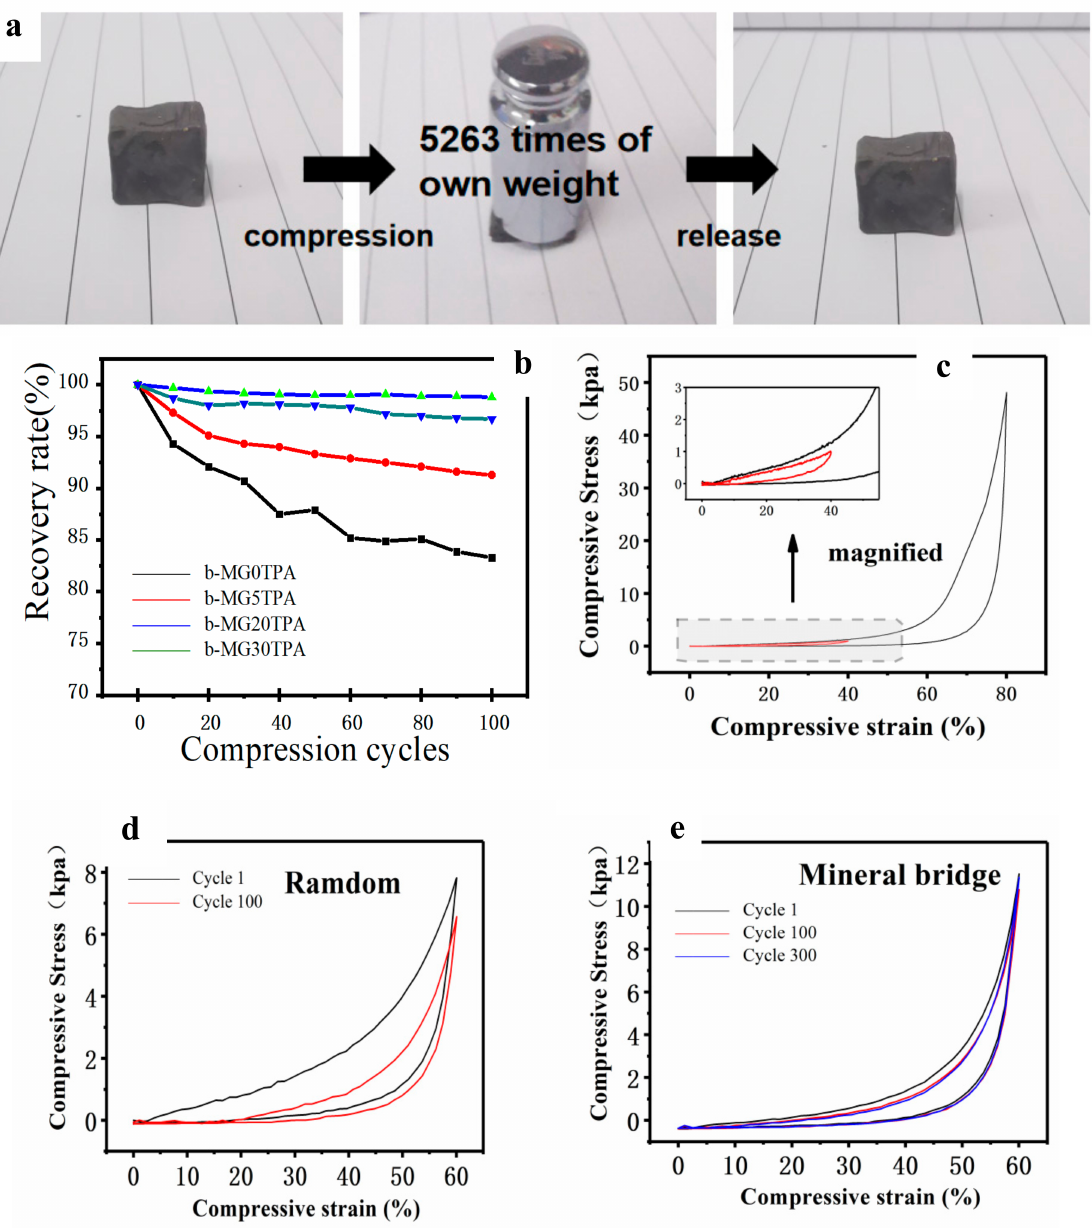
Figure 5. ( a ) Demonstration of the high compressibility and recoverability of MGTPA. ( b ) Recov- ery rate of different aerogels in cyclic compression tests. All samples were compressed to 60% strain and released to 0% strain for 100 cycles. ( c ) Stress − strain curves of b-MG 20 TPA at 40% and 80% strain. Comparison between ( d ) random and ( e ) biomimetic structure aerogels in their compression − recovery